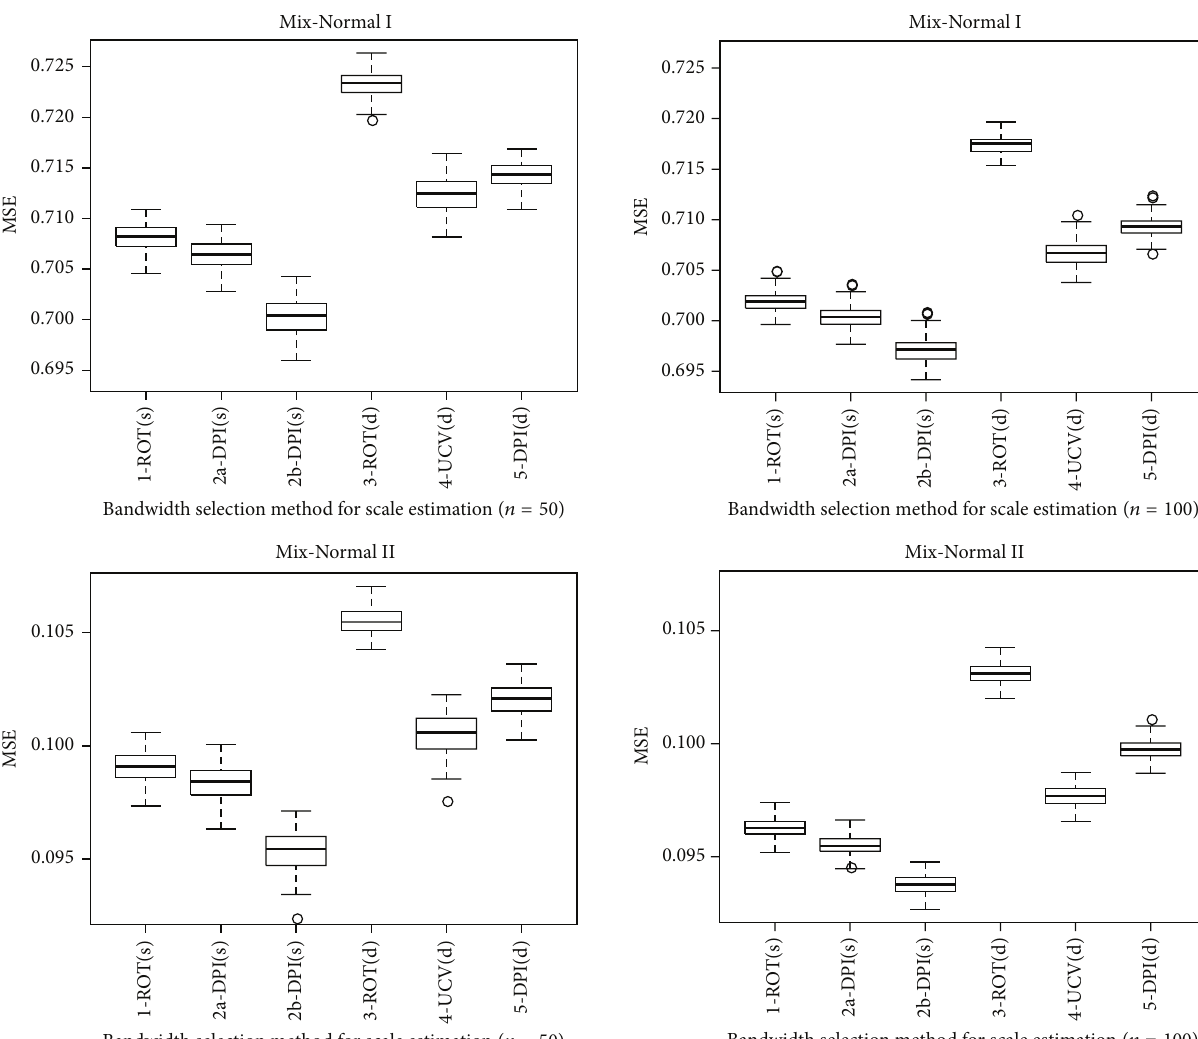
̂ℎ ; “2a-DPI(s)” means with pilot bandwidth ROT ;𝑈 1 DPI ;𝑈 1 ̂ℎ ̂ℎ ; “4-UCV(d)” means ; “5- ROT ; density LSCV ; density